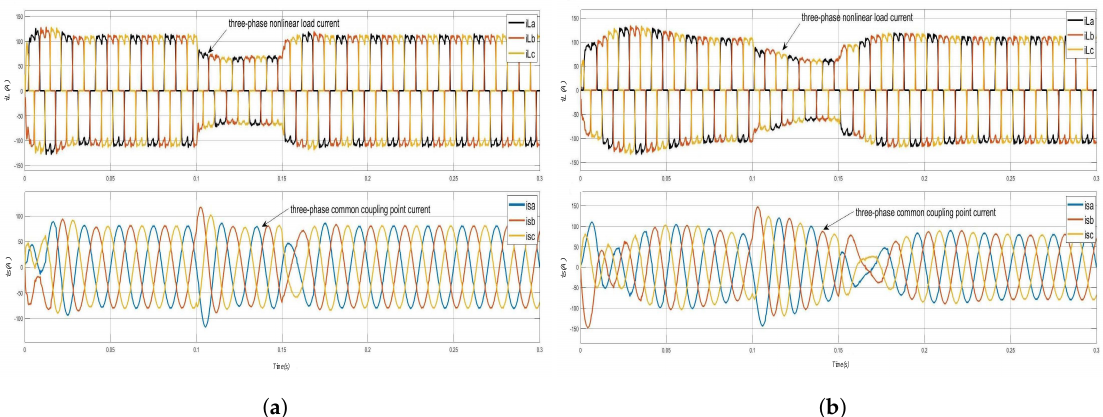
Figure 14. ( a ) Three-phase nonlinear load current and grid current of Scheme I; ( b ) three-phase nonlinear load current and grid current of Scheme